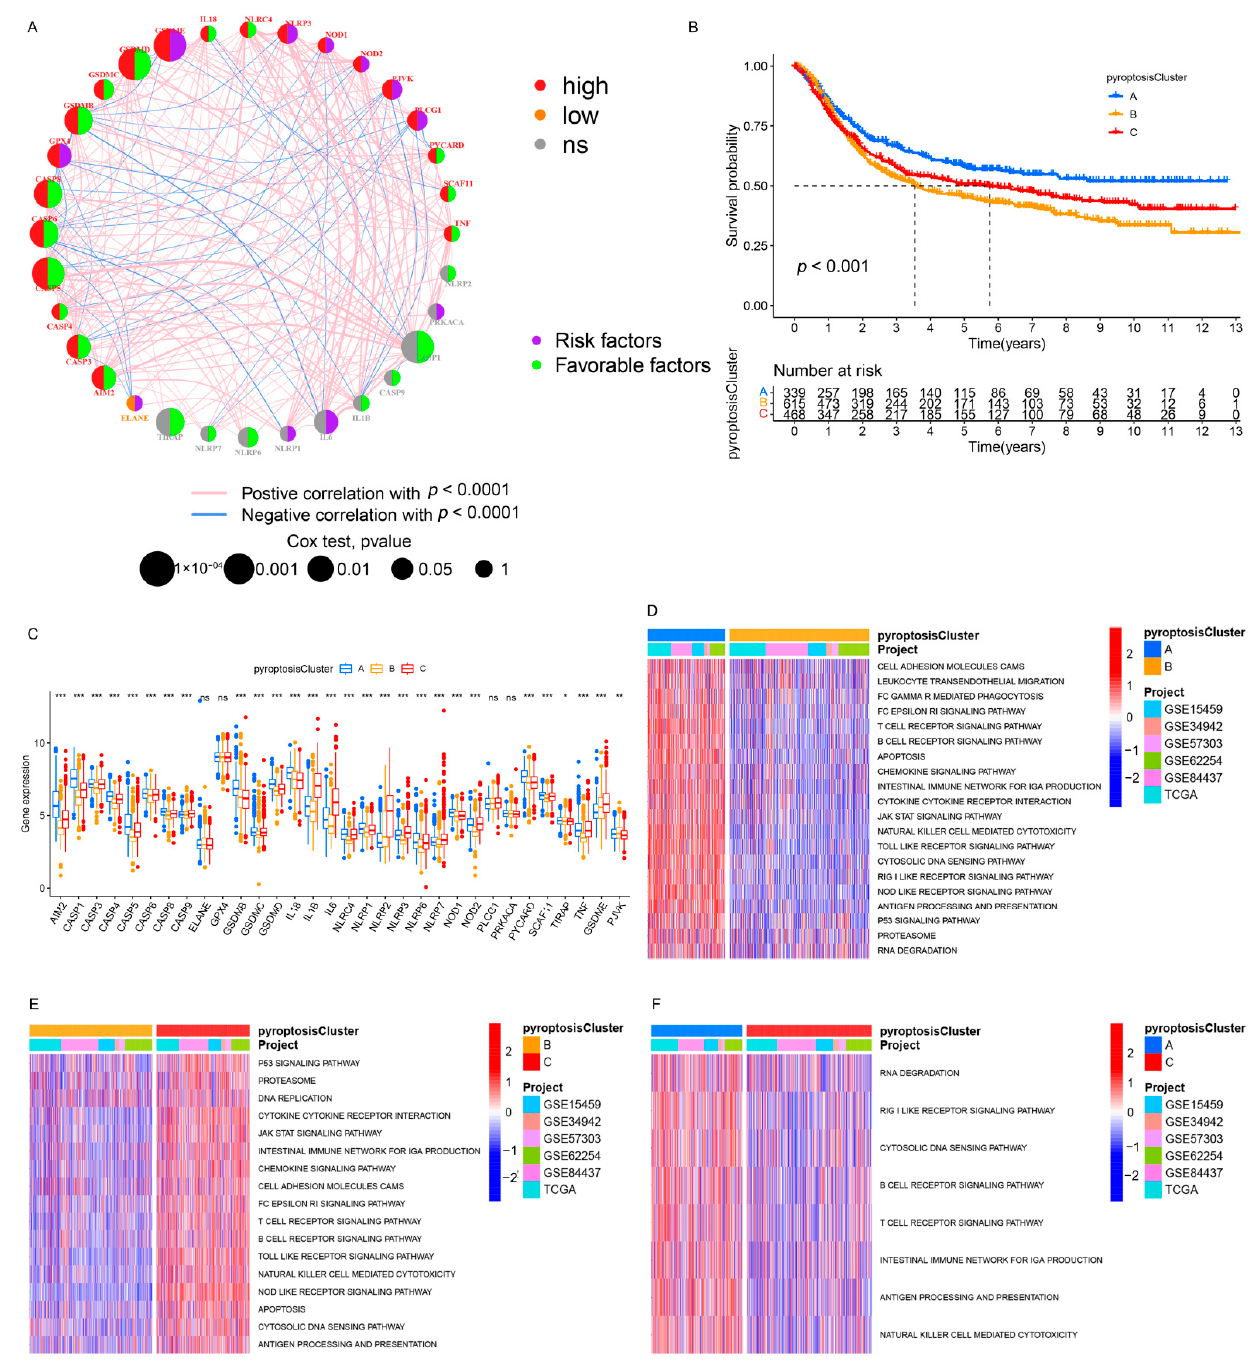
Figure 2. Pyroptosis patterns and relevant biological pathway. ( A ) The interaction between PRs in GC. The circle size indicated the effect of PRs on the prognosis, and the range of values calculated by the Cox test was p < 1 × 10 − 4 , p < 0.001, p < 0.01, p < 0.05, and p < 0.1, respectively. Purple semicircle on the right, risk factors; green semicircle on the right, favorable factors. Red semicircle on the left, upregulated PRs in GC; orange semicircle on the left, downregulated PRs in GC; gray semicircle on the left, no difference in expression. The lines connecting PRs represented their interactions, and the thickness represented the correlation strength between PRs. The blue line marked a negative correlation, and the red line marked a positive correlation. ( B ) Kaplan–Meier analysis of the OS for 1422 GC patients in the meta-cohort with different pyroptosis patterns (Log-rank test: p < 0.001). ( C ) Differential expression analysis of PRs among three pyroptosis patterns. ( D – F ) GSVA enrichment analysis. The heatmap was used for visualizing pathways, and red indicated activated pathways and blue indicated inhibited pathways. ( D ) Pyroptosis cluster A vs. pyroptosis cluster B. ( E ) Pyroptosis cluster B vs. pyroptosis cluster C. ( F ) Pyroptosis cluster A vs. pyroptosis cluster C. * p < 0.05; ** p < 0.01; *** p <